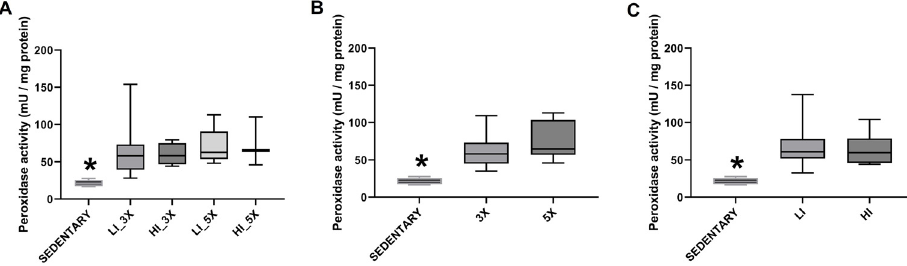
Figure 5. Median and interquartile range of peroxidase activity in renal tissue samples from groups (sedentary, trained at low [LI] and high [HI] intensity, three times [3X] and fi ve times [5X] per week) ( A ) and according to animals grouped by training frequency (three and fi ve times per week) ( B ) and training intensity (low and high intensity) ( C ). *P o 0.05 compared with all trained groups (Kruskal-Wallis).